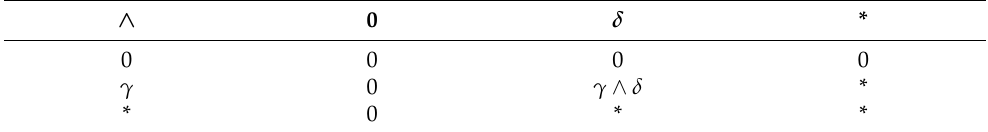
Table 2. Definability of connectives